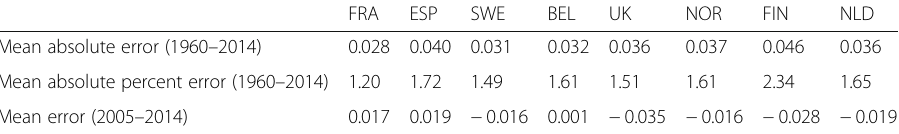
Table 2 Mean absolute (percent) error over the period 1960 – 2014 and mean error over the period 2005 – 2014 of the log death rates limited to age 65 and above of the Lee-Carter forecast estimated over the period 1960 – 2014, for eight Western European countries, men and women combined FRA ESP SWE BEL UK NOR FIN NLD Mean absolute error (1960 – 2014) 0.028 0.040 0.031 0.032 0.036 0.037 0.046 0.036 Mean absolute percent error (1960 – 2014) 1.20 Mean error (2005 –